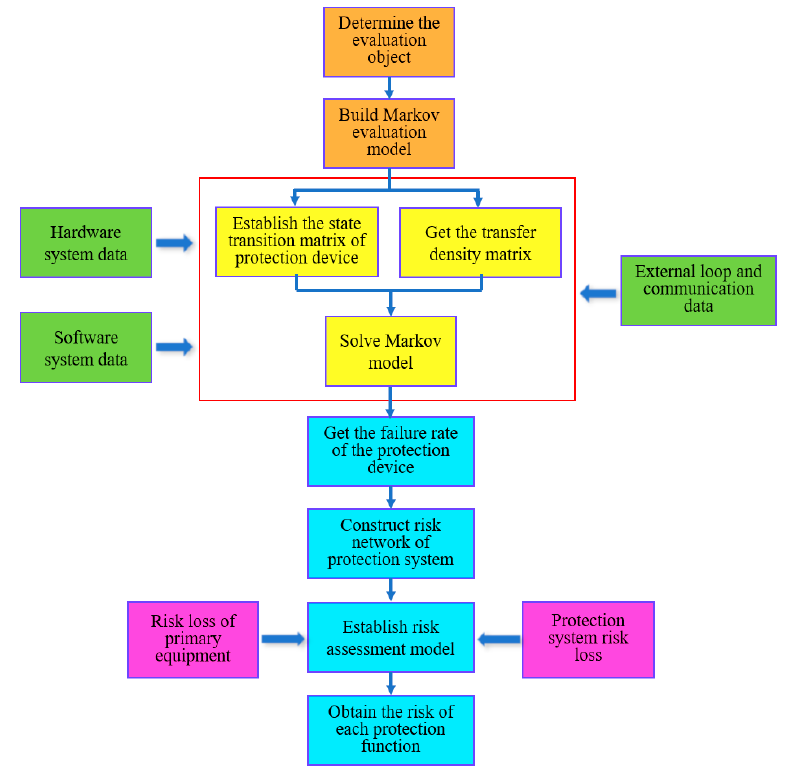
Figure 5. Risk assessment process of relay protection system.